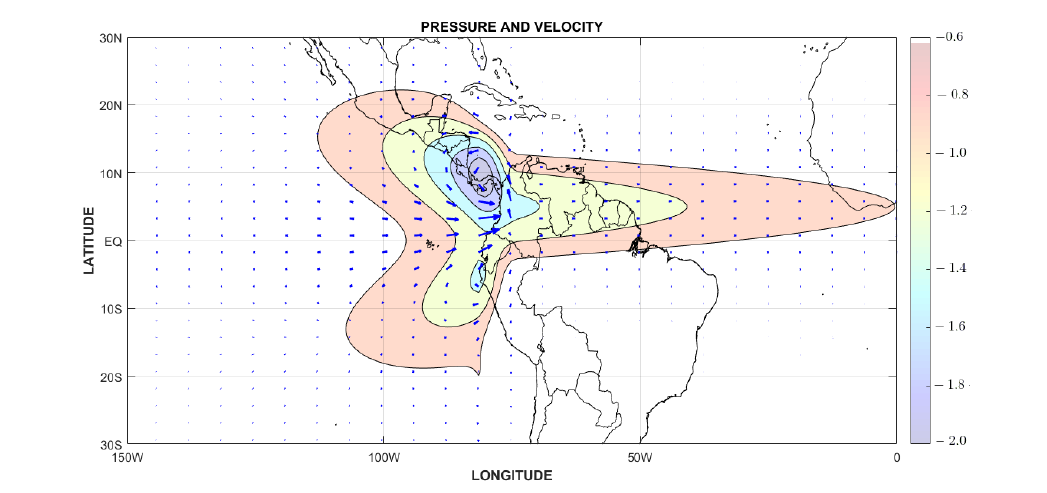
Figure 5. Surface flow (wind arrows) and pressure contours over Northern South America and Meso-America for a diabatic heating source located at 5 ◦ N ( k = 4, a = 5, I = 1 and y 0 =